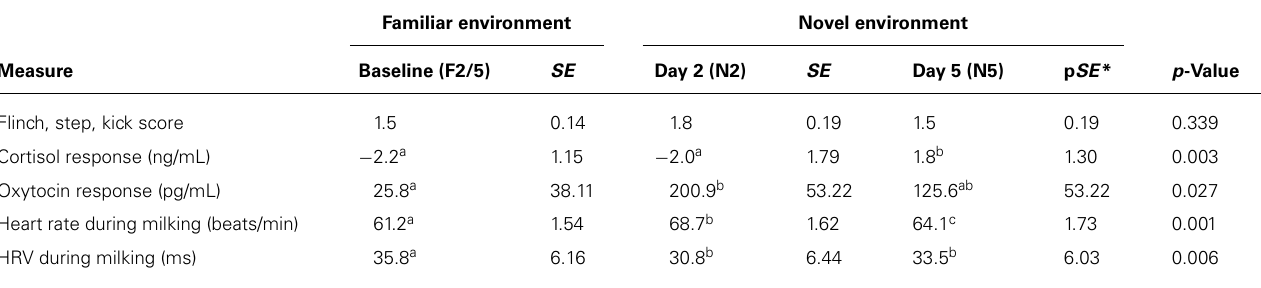
Table 1 | Least square mean ( SD ) behavioral and physiological response of cows milked in a familiar (Baseline) and a novel environment. Familiar environment Novel environment